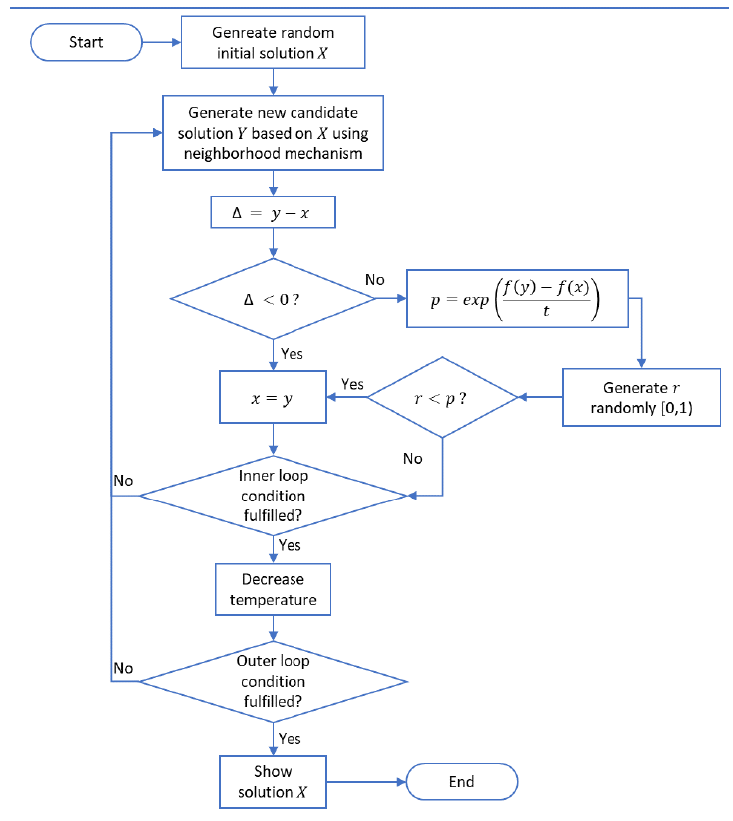
Figure 2. Flowchart of the SA optimization process.